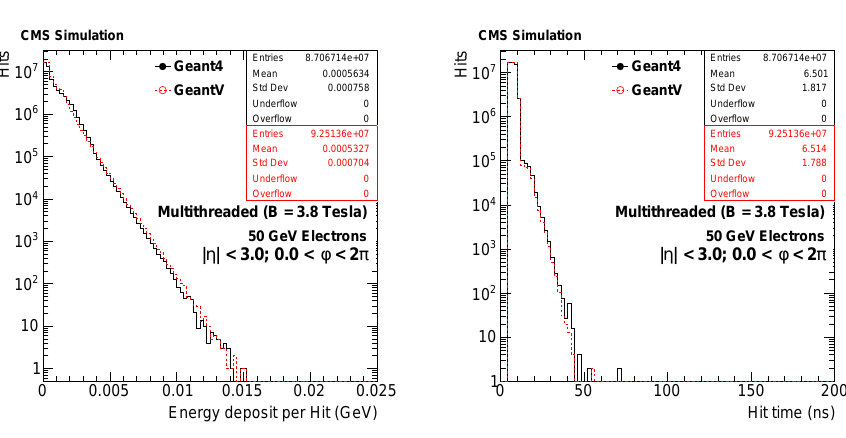
Figure 4. The distributions of deposited energy and time for each simulated hit in the ECAL barrel, comparing G eant 4 and G eant V. The hits originate from a simulation of single electrons with E = 50GeV and random η and φ